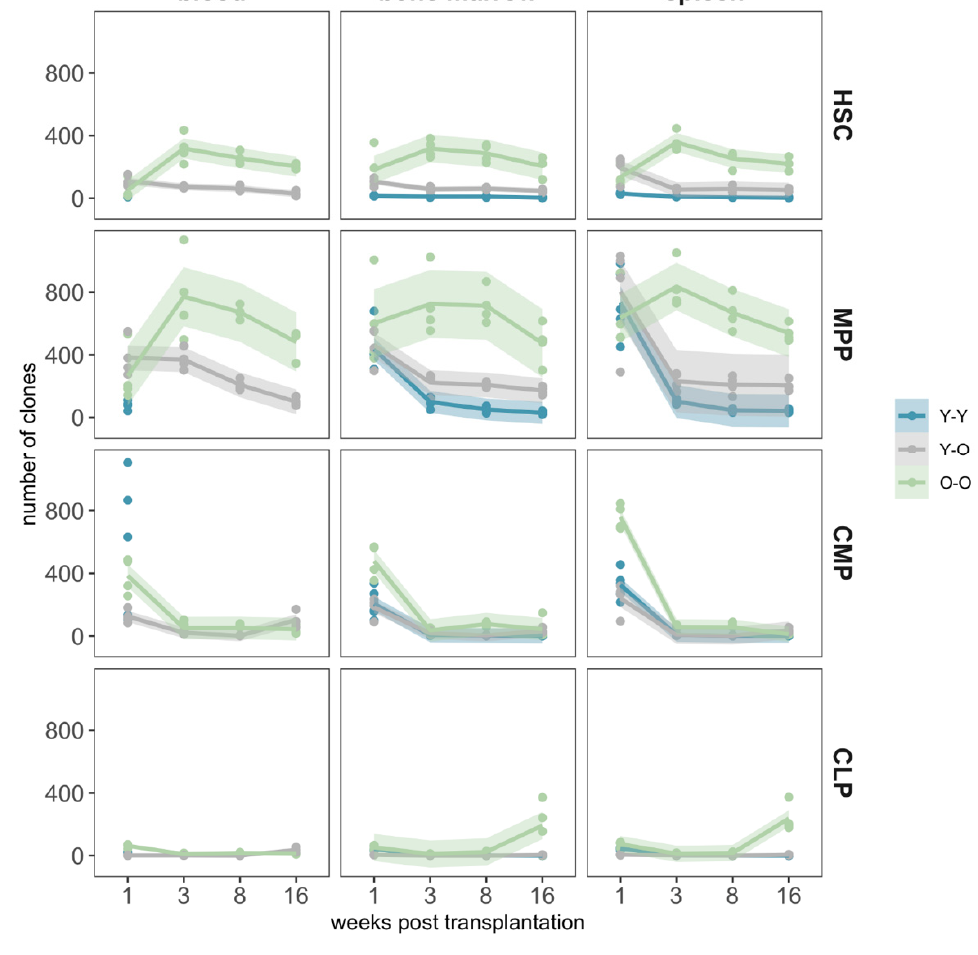
Figure 4. Mean barcode content. We extracted the DNA from peripheral blood, bone marrow, and spleen and amplified the BC32 sequences by PCR. NGS and subsequent bioinformatic analyses showed the number of unique barcodes from the initially marked cell population in the respective organ, corrected by the vector copy number (VCN). For a better representation of the reconstitution dynamics, we used fitted local polynomial regression curves (lines) including their respective 95% confidence bands (shaded regions) to link the individual clone numbers (points). Blue data represent the Y-Y experimental setting, grey data represent the Y-O experimental setting, and light green data represent the O-O experimental setting. The data points from the Y-Y setting are mostly overlayed by the others.